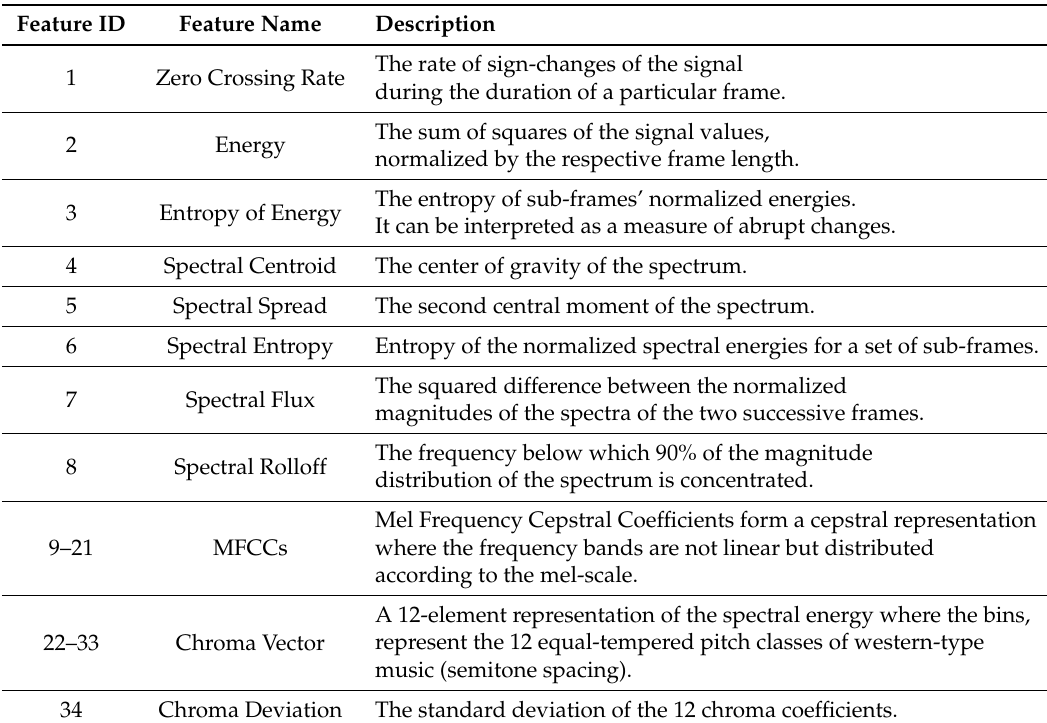
Table 2. Audio-based handcrafted features used to train an SVM classifier with